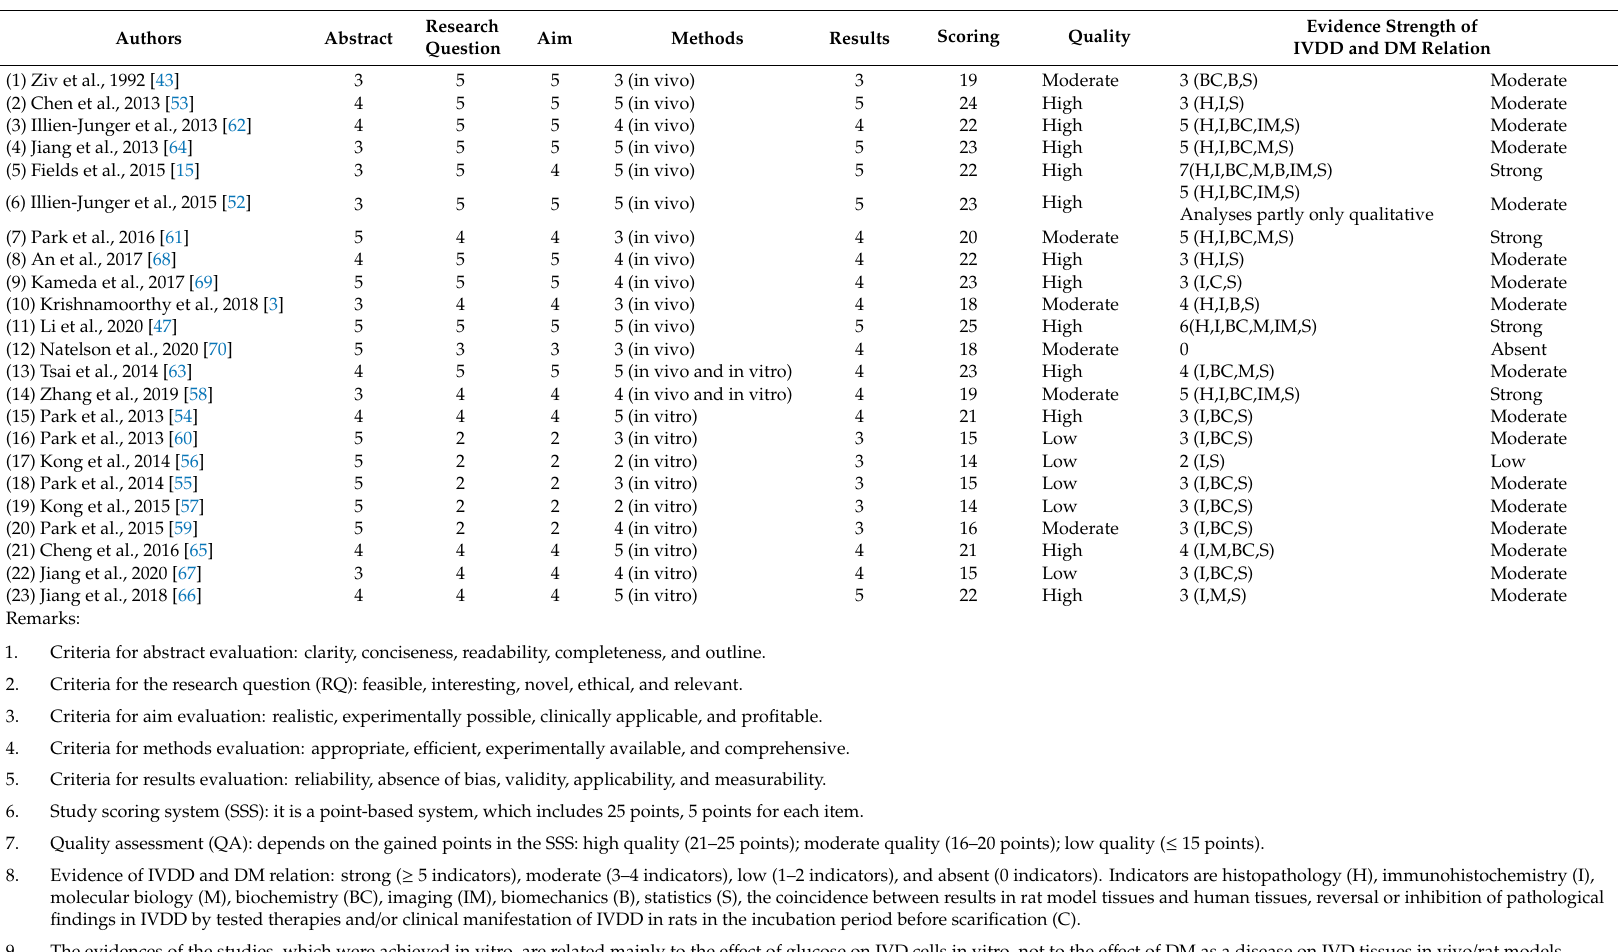
Table 5. Study evaluation with